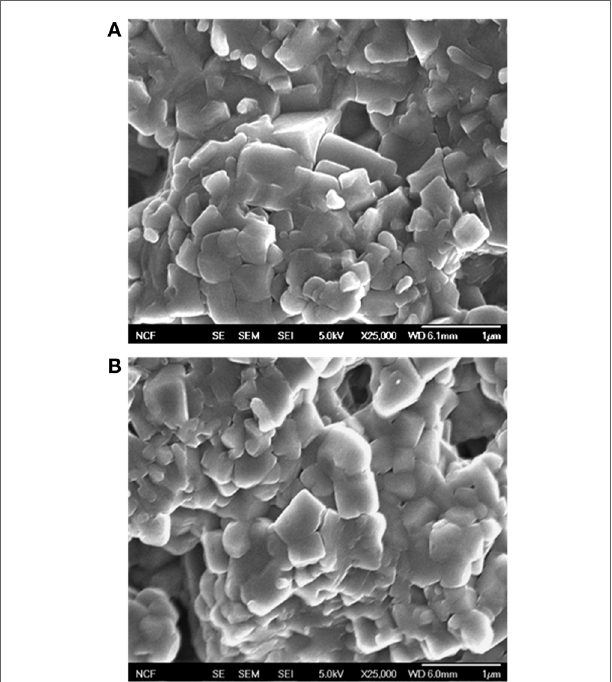
FigUre 6 | seM micrographs of selected fracture surfaces . (a) HF sintered and (B) conventionally